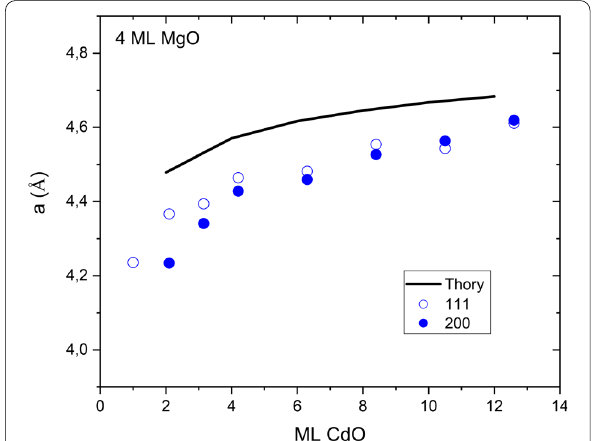
Fig. 9 Comparison of the theoretical lattice constant (solid line) and experimental data (symbols: open for samples grown on 111 direction, full for samples grown on 001 direction) for series of SLs with different thickness of CdO